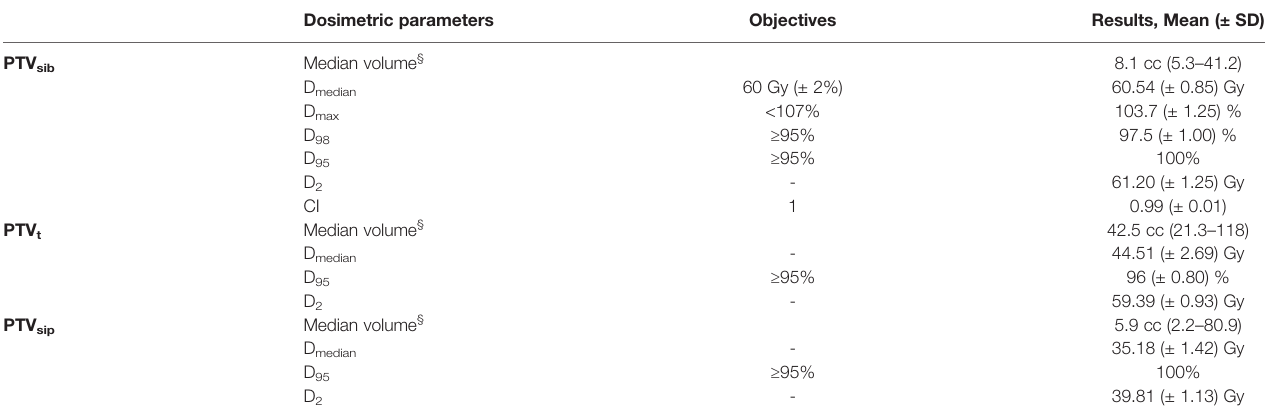
TABLE 3 | Treatment plan analysis for PTVs*.